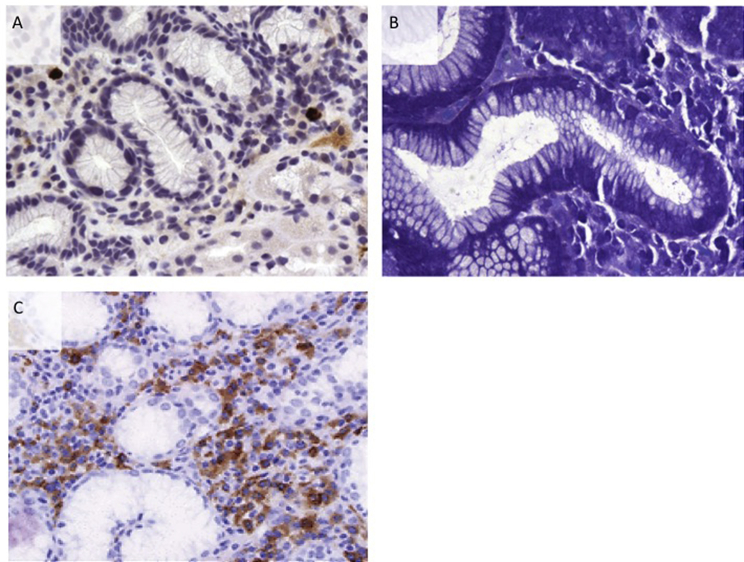
(A): DAB-positive (brown) IgG4-positive plasma cells in gastric tissue of an AIP patient. (B):H. pylori-associated gastritis with lymphocytes and neutrophils in an AIP patient. (C): DAB-positive (brown) IgG4-positive plasma cells in a duodenal biopsy in a patient with AIP (IgG4 cells >10 per high power field).